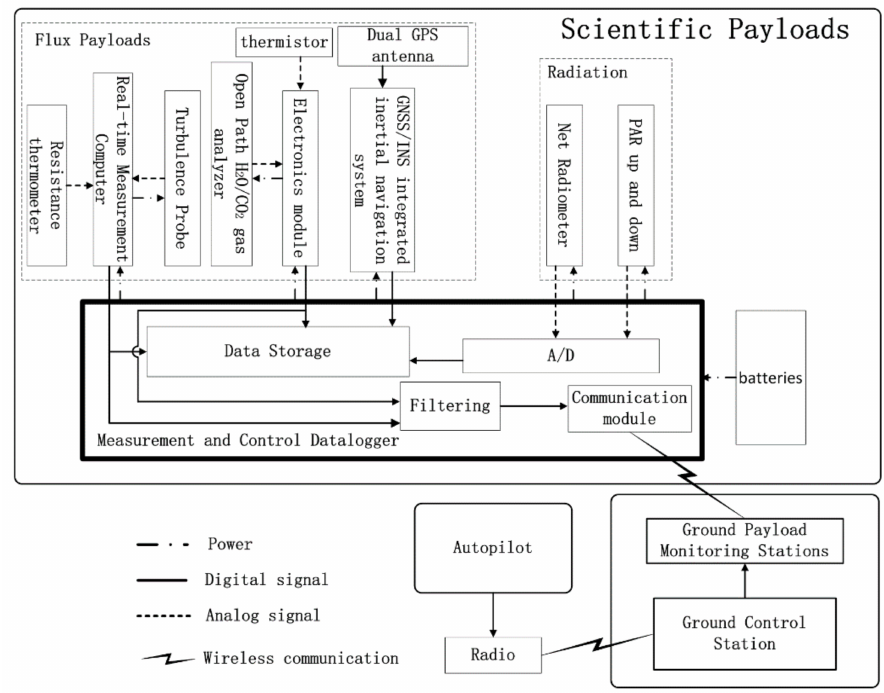
Figure 2. Diagram of the developed UAV-based EC system. Solid arrows represent the digital signal, dashed arrows represent the analog data (measured with the analog-to-digital boards), dotted arrows represent the power supply, and the lightning mark represents radio